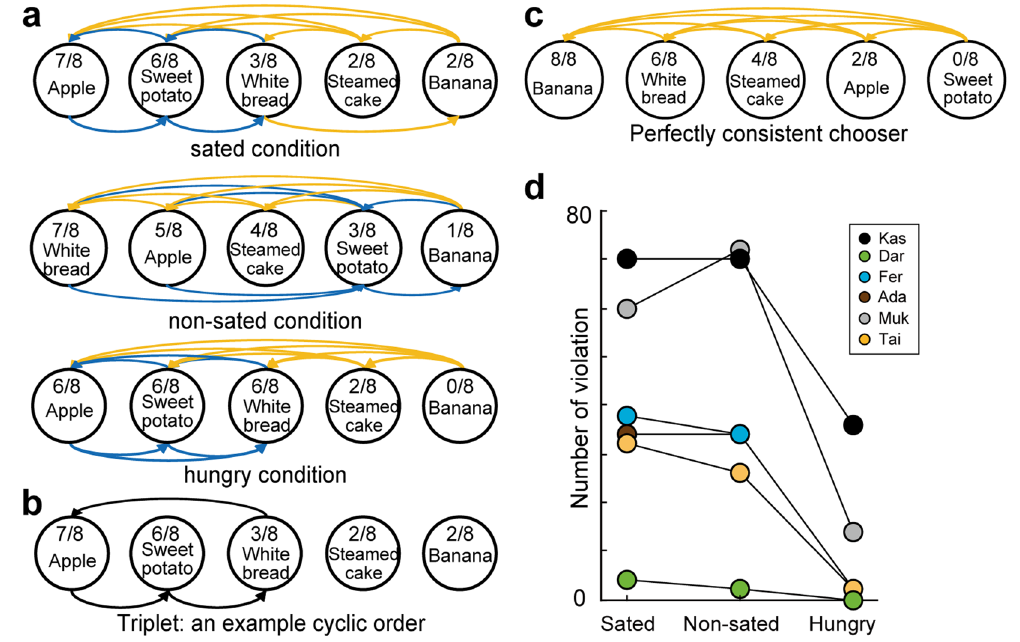
Figure 3. Transitivity violations decreased when monkeys were hungry. ( a ) The structure of preferences in monkey Ada in the three food access conditions. The items are ordered left-to-right according to the preference scores. Arrows are connected from an unchosen item to a chosen item. Yellow arrows indicate that the monkey chose one item over another item twice. Blue arrows indicate split choices (chose each item once). ( b ) An example of the transitivity violation in a triplet in monkey Ada in the sated condition. ( c ) Example choices made by a hypothetical chooser with perfectly consistent behavior. ( d ) The number of transitivity violations equal to or larger than